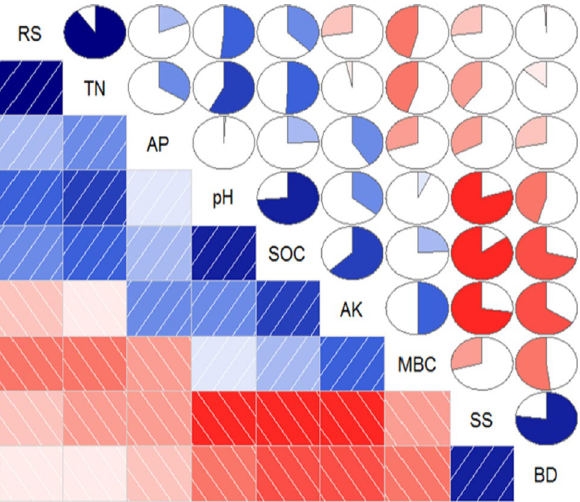
Figure 6. Correlation analysis between the soil respiration and soil physico-chemical properties. Red rectangles and circles indicate a negative relationship between different properties; blue rectangles and circles indicate a positive relationship between different properties; the area of the colour in the circle indicates the correlation coefficient, and the darker red or blue colours indicate a closer relationship. RS, soil respiration; BD, bulk density; SS, soluble salts; SOC, soil organic carbon; MBC, microbial biomass carbon; TN, total nitrogen; AP, available phosphorus; and AK, available